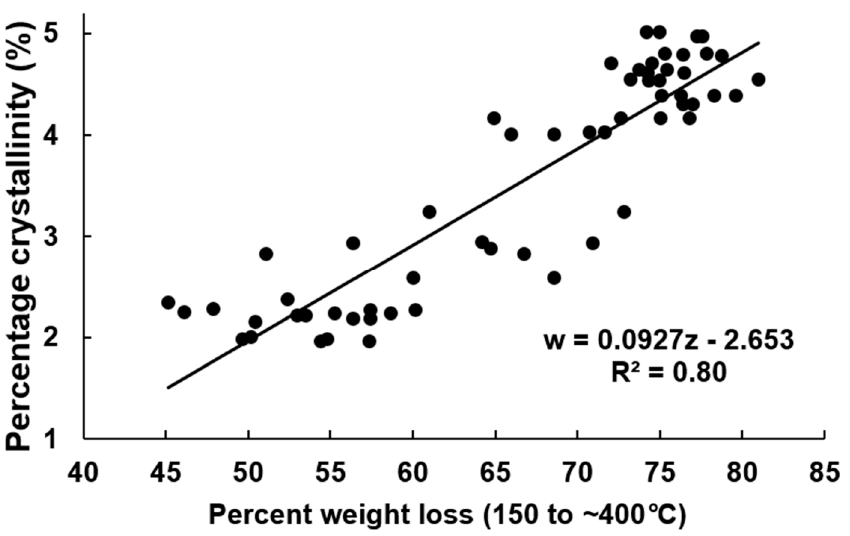
Figure 10. Percent crystallinity as a function of the weight loss percent in the region from 150 to ~400 °C.